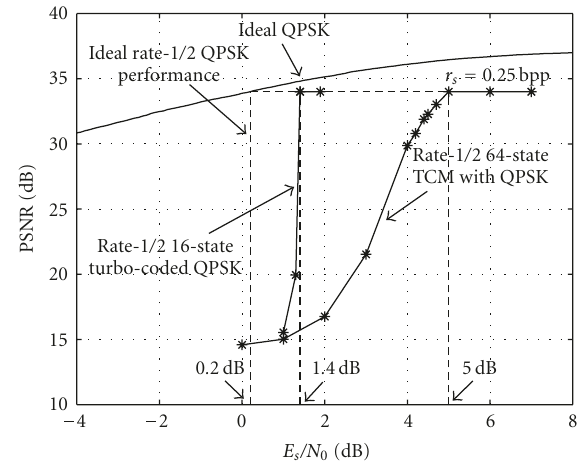
Figure 6: PSNR versus E s /N 0 performance of using rate-1/2 turbo coded QPSK for transmitting the SPIHT compressed 512 image using 65,536 symbols (with r s = 0 . 25bpp).